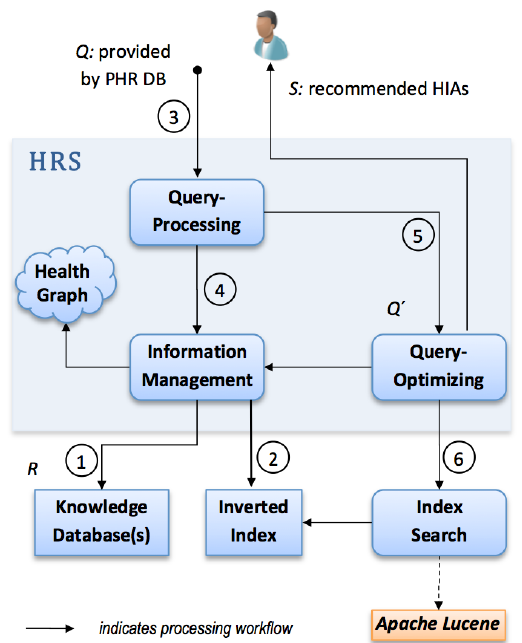
Figure 3. System structure and processing workflow of our HRS prototype and attached data sources. A PHR system feeds in data elements via Q . The process yields a set of recommendable items S which are highly relevant to a PHR